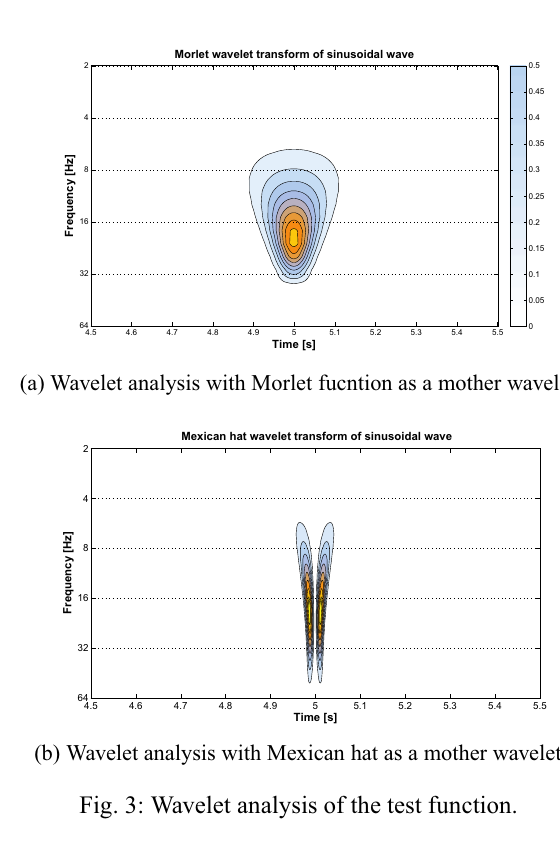
Fig. 2: Test function - simple wave with frequency of 20 Hz.